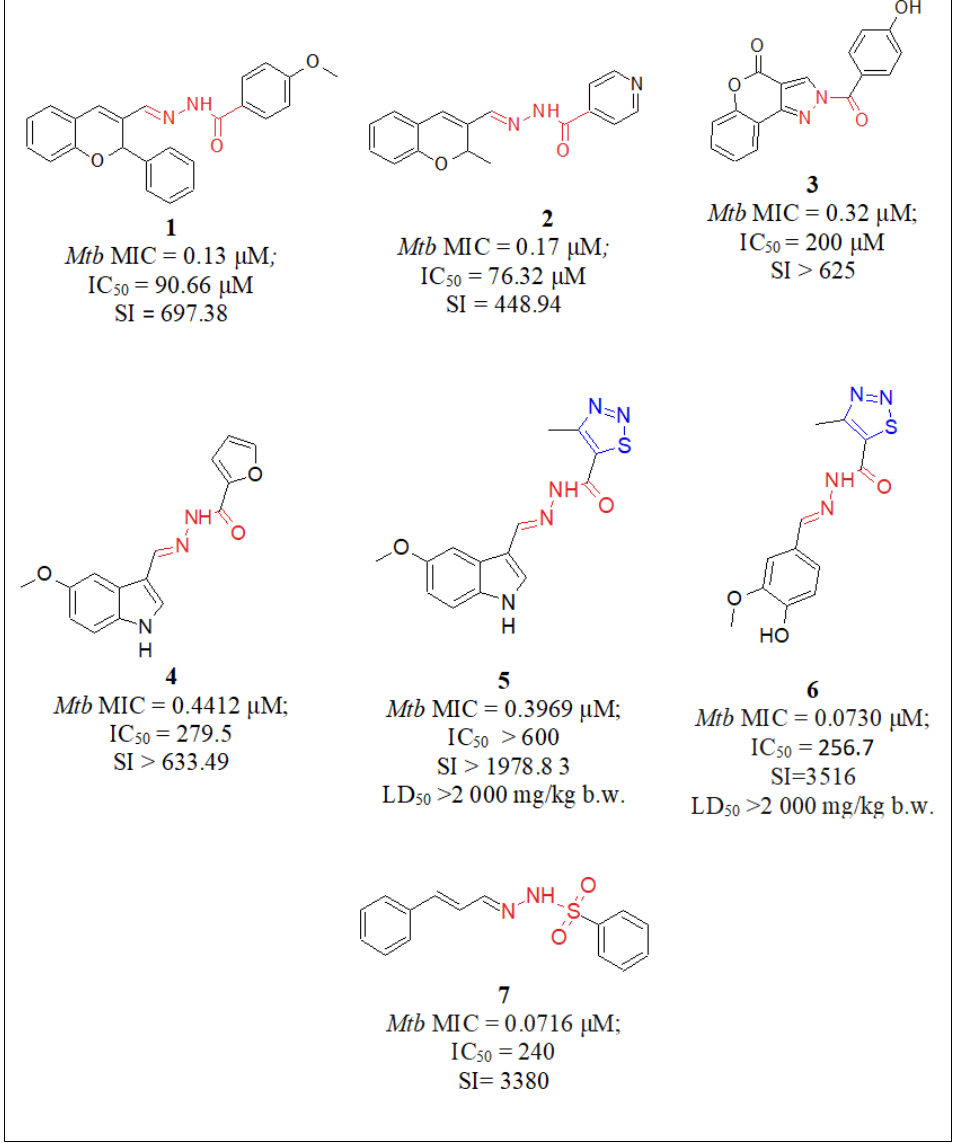
Figure 5. Chemical structures of compounds 1 [28] , 2 [28] , 3 [29,30] , 4 [30] , 5 [30] , 6 [31] and 7 [31]